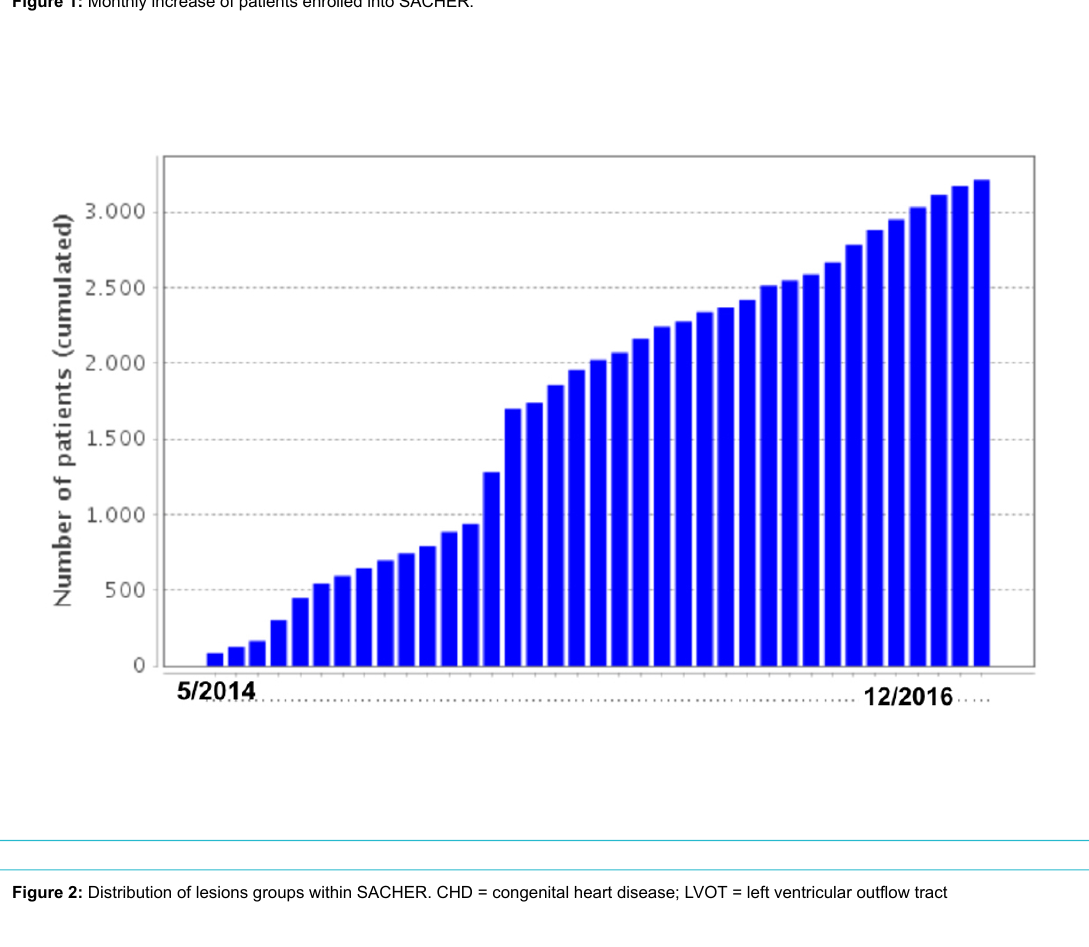
Figure 1: Monthly increase of patients enrolled into SACHER.